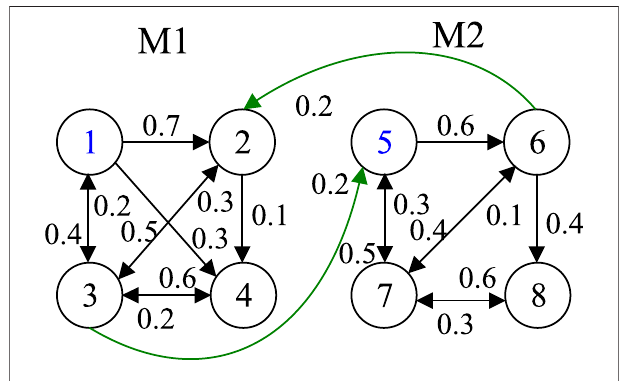
FIGURE 2 | Change propagation network between module M 1 and module M 2